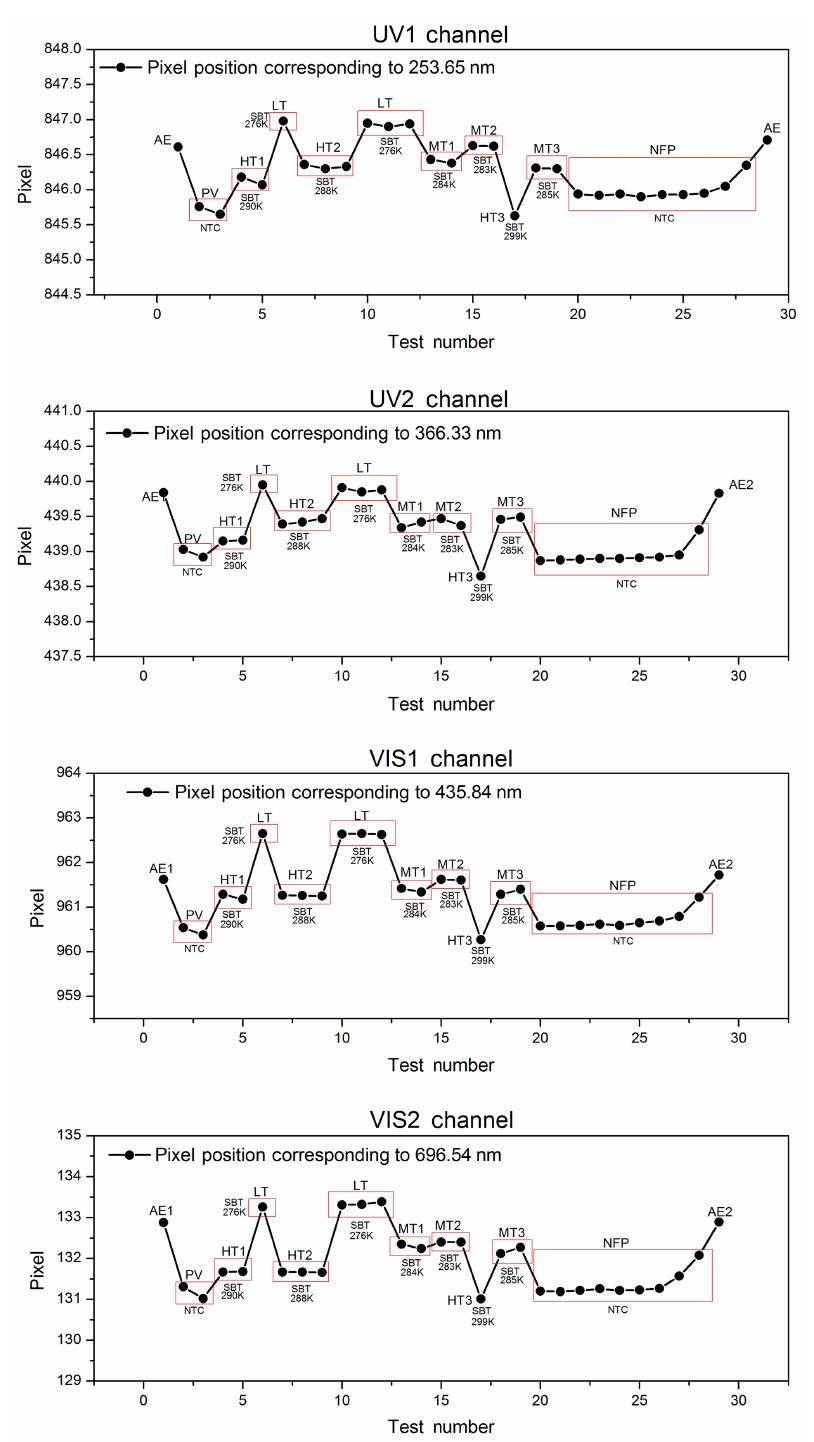
Figure 5. Wavelength shifts from the atmospheric environment to vacuum: UV1/0.8 pixel (approximately 0.06nm), UV2/0.8 pixel (ap- proximately 0.07nm), VIS1/1 pixel (approximately 0.1nm), VIS2/1.5 pixel (approximately 0.2nm); Wavelength shifts from HT1 to LT in vacuum: UV1/1 pixel (approximately 0.1nm), UV2/1 pixel (approximately 0.1nm), VIS1/1.5 pixel (approximately 0.2nm), VIS2/1.5 pixel (approximately